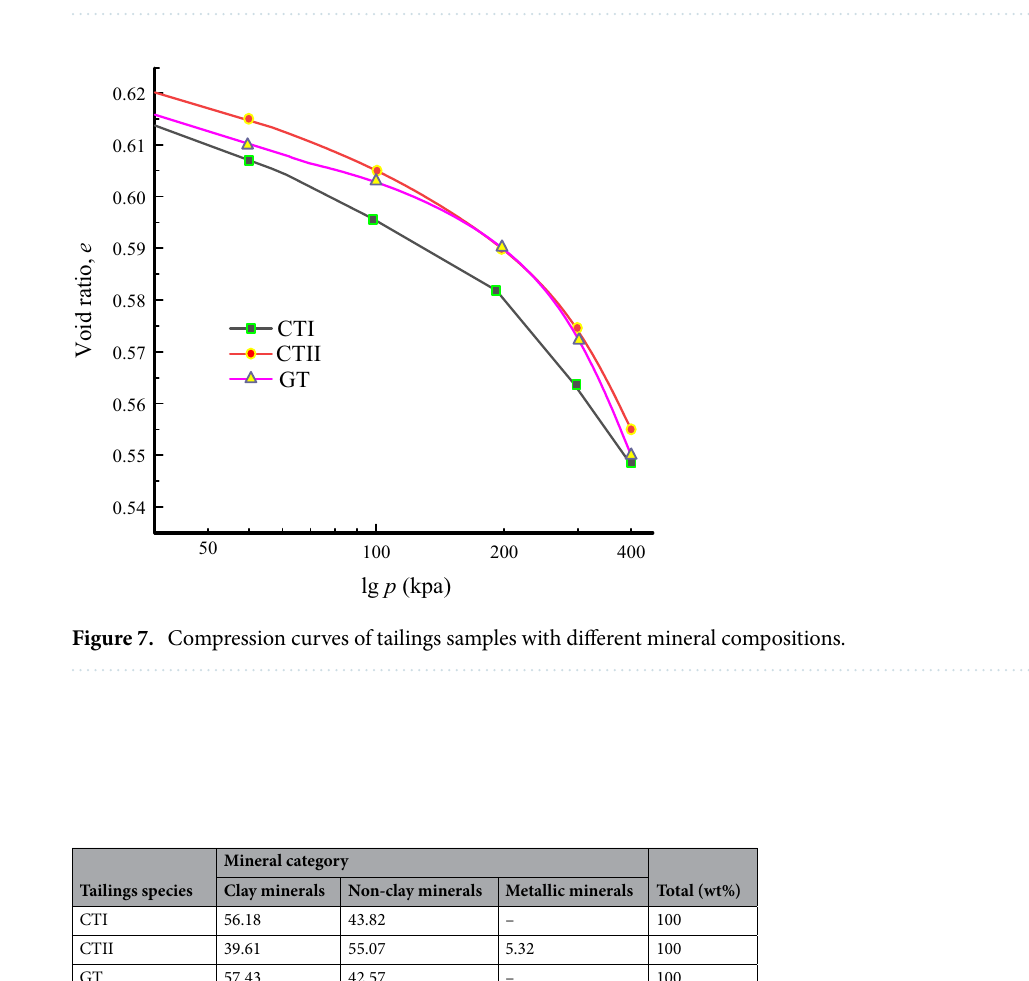
Figure 6. Schematic diagram of the triaxial test apparatus.